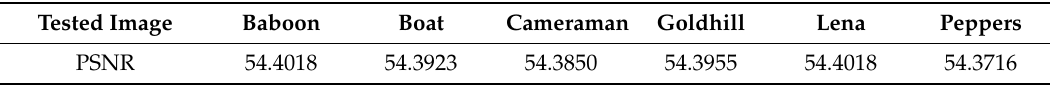
Figure 9. Stego images (512 × 512): Baboon, Boat, Cameraman, Goldhill, Lena, and Peppers. Table 6. Stego Image Quality.